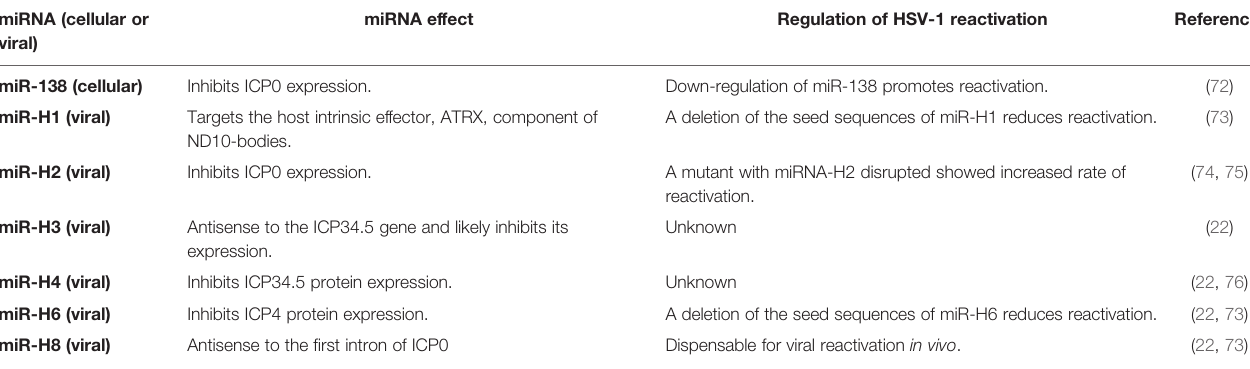
TABLE 1 | Summary of miRNA modulation of HSV-1 reactivation. miRNA (cellular or